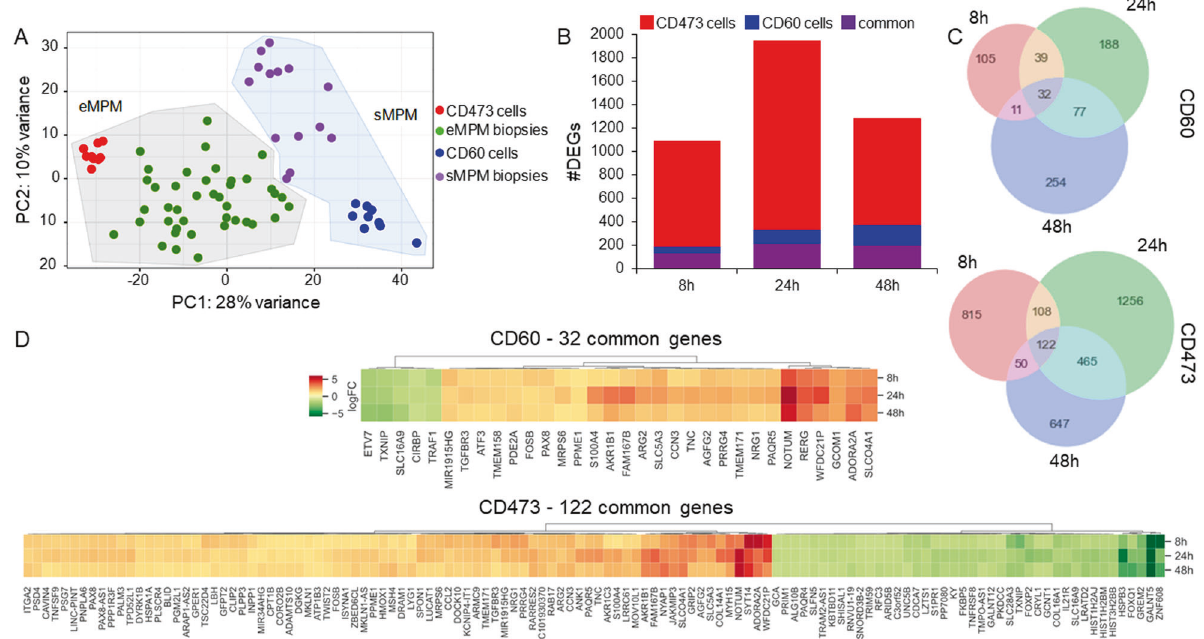
Fig. 5 Transcriptomic analysis of control and treated samples. A Principal component analysis of the transcriptional pro fi les of control CD60 and CD473 cells and MPM patient biopsies (eMPM epithelioid MPM, sMPM sarcomatoid MPM, PC principal component). B Number (#) of DEGs. C Venn diagrams of DEGs. D Fold-changes of the common regulated genes in epithelioid CD473 and sarcomatoid CD60 cells at 8, 24 and 48 h of 1.12 V/cm TTFields